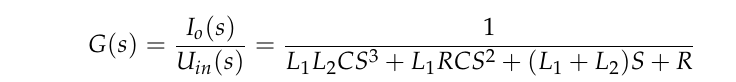
Figure 4. Equivalent circuit model added to load the main topology circuit switch model.